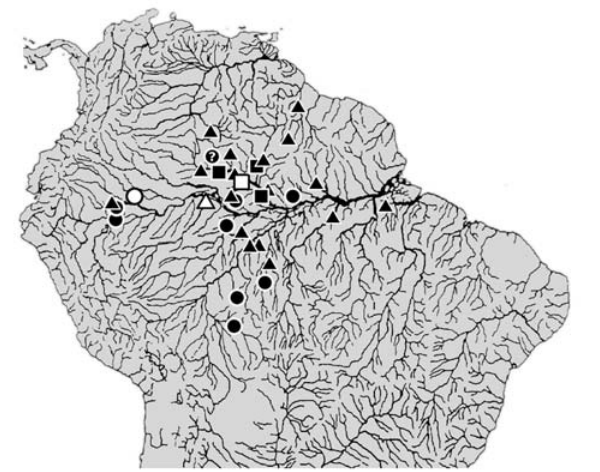
Fig. 6. Geographic distribution of Physopyxis lyra (circle), Physopyxis ananas (triangle), and Physopyxis cristata (squares). Open symbols are type localities. Record of P. lyra in rio Negro